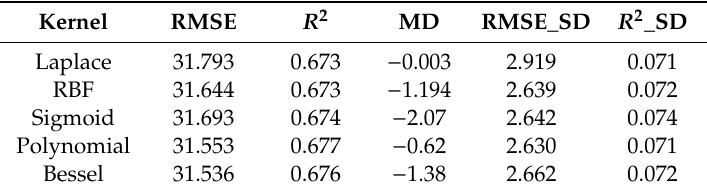
Table 6. Sentinel-2 modeling with 31 features.